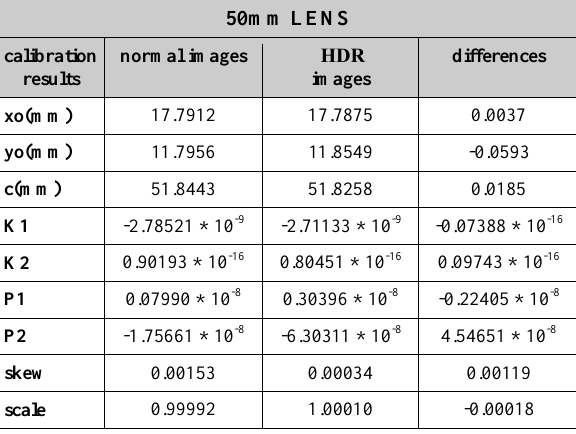
Table 2: Calibration results and comparison between normal and HDR images with 50mm focal length lens